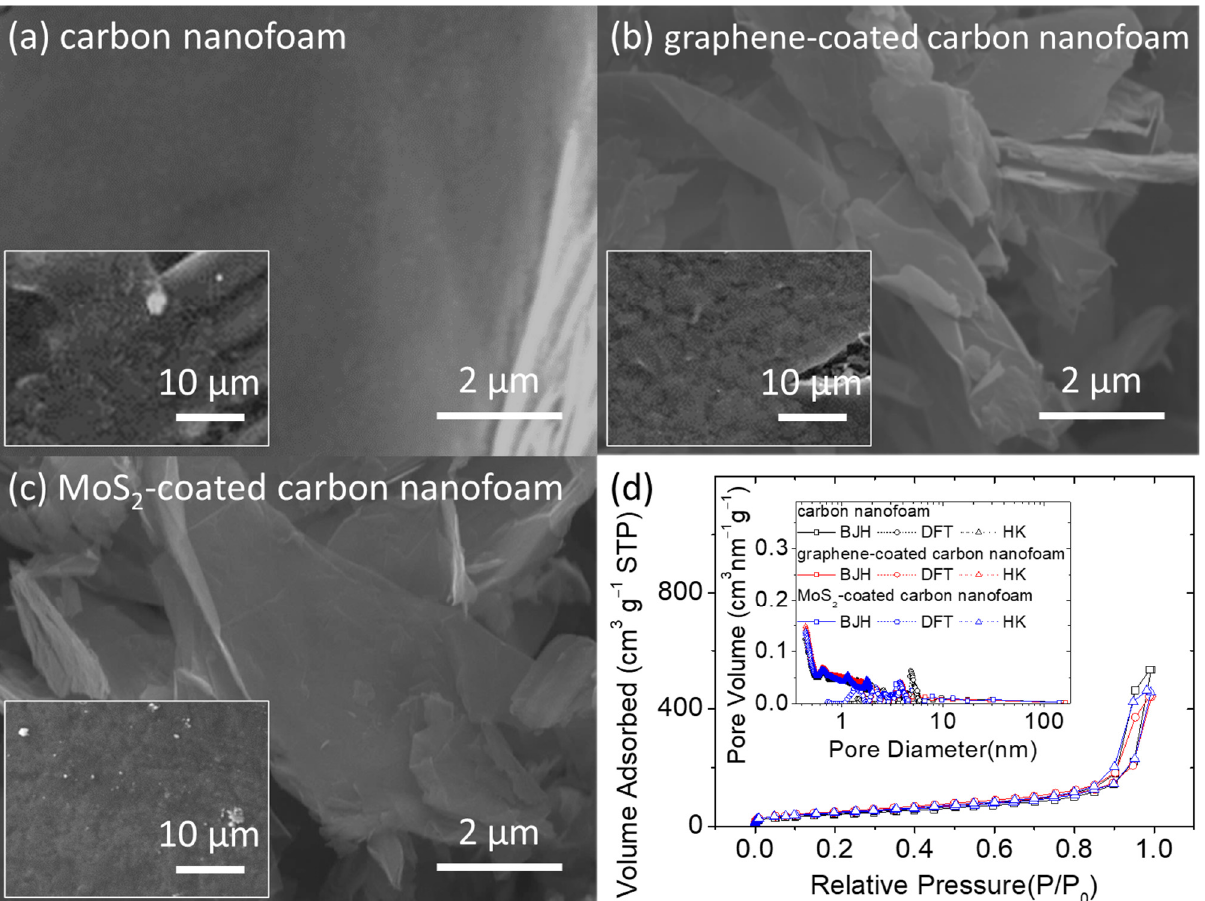
Figure 1. Material characterization: microstructural inspection of ( a ) carbon nanofoam, ( b ) graphene-coated carbon nanofoam, and ( c ) MoS 2 -coated carbon nanofoam. ( d ) Nitrogen adsorption–desorption isotherms; inset shows pore analysis by adsorption.